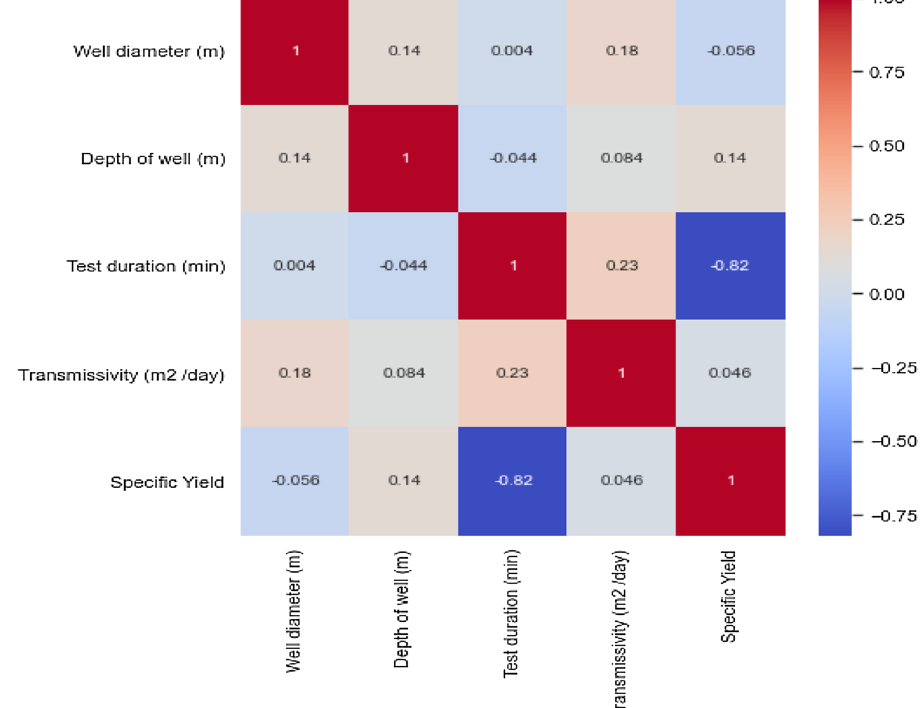
Fig. 29 Theis’s method of pumping well-12 Fig. 30 Correlation heat of aquifer